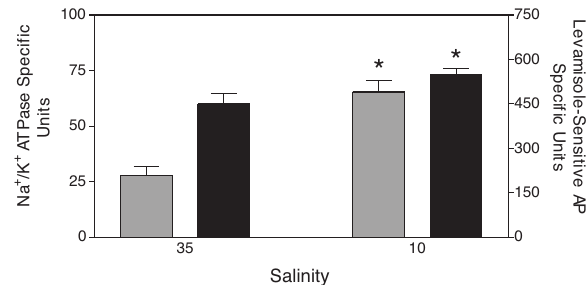
f ig . 8. – effect of acclimation to low salinity on na + -K + atPase activity (grey bars) and levamisole-sensitive aP activity at pH 7.4 (black bars) in chela muscle of C. angulatus . data are the mean ± S.e. number of specimens given in table 2. * Significantly different from the corresponding activity of individuals acclimated to 35 psu (p<0.05). Units: na + -K + atPase: nmol Pi x min -1 x mg prot -1 ,